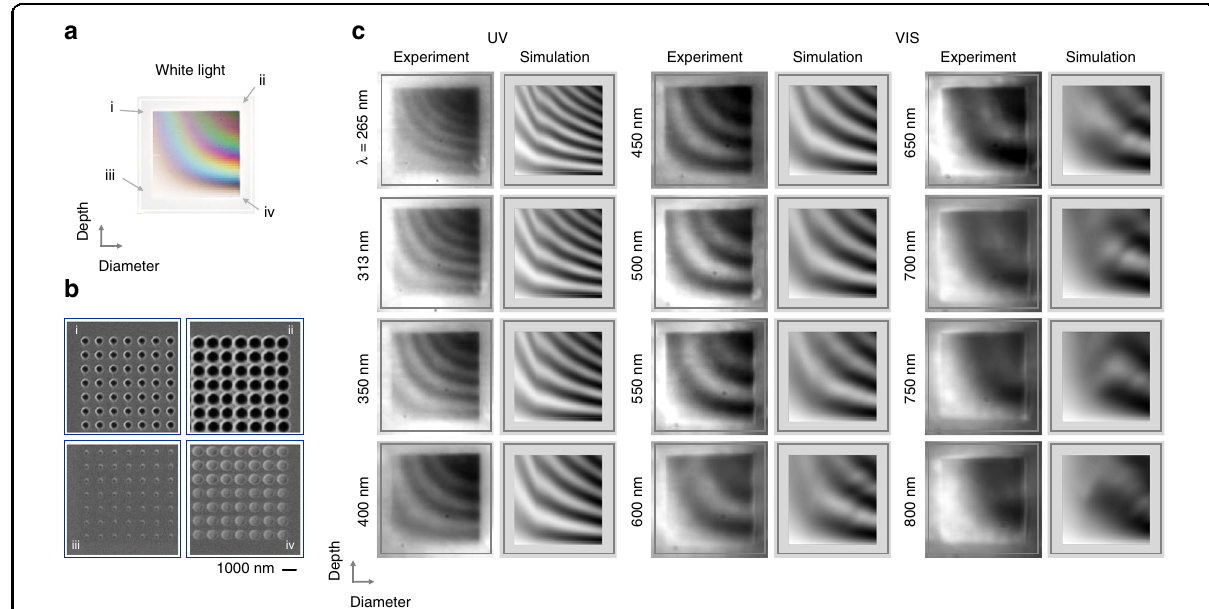
Fig. 4 Experimental observation of modes in the UV and visible spectral range. a White light re fl ection image of an array of dielectric voids in silicon. The size as well as the depth are varied in 36 steps each. The diameters range from ~330 nm to 750 nm and the depth from ~20 nm to 1100 nm (all parameters can be found in the Supporting Information). b SEM images taken from the void array at the positions indicated in ( a ). The images are taken for the smallest diameter voids for smallest and highest dose (shallowest (iii) and deepest voids (i), respectively) as well as for the largest void diameter for smallest and highest dose (shallowest (iv) and deepest (ii) voids, respectively). c Experimental and simulated monochromatic images of the void array for the indicated wavelengths (displayed as vertical labels on the left). In the experiments, band pass fi lters at the speci fi ed centre wavelength are used to limit the wavelength range. With decreasing wavelength, an increasing number of modes can be observed. Due to the shorter wavelength, more and more higher-order modes can be resonantly excited. It is noteworthy, that this behaviour depends both on the depth as well as the diameter, ruling out trivial interference effects. In the UV spectral range at 265 nm or 4.7 eV, one experimentally observes seven distinct higher-order modes. The simulated optical response is in good agreement with the